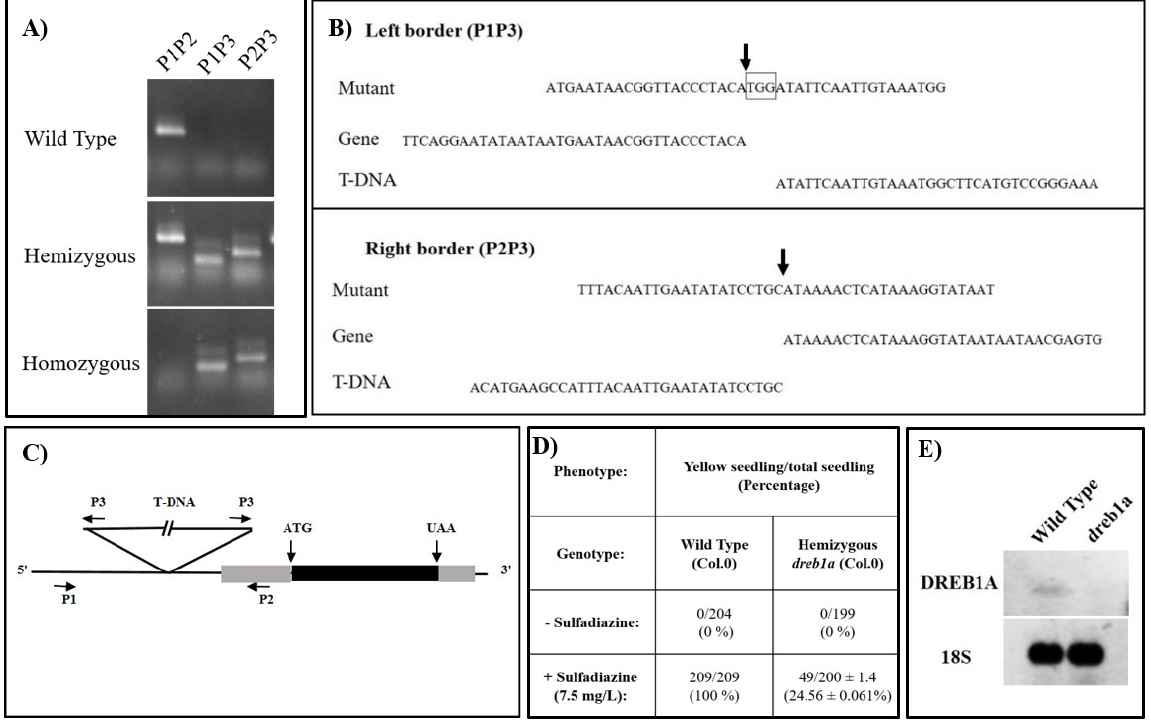
Fig. 1. Molecular identification of the T-DNA insertion in the dreb1a mutant: A) PCR amplifications using DREB1A gene-specific primers (P1 and P2) and the T-DNA specific primers (P3 and P4); B) The status of the T- DNA junctions in the dreb1a plant. Nucleotide sequences of the dreb1a plant were aligned with that of the DREB1A gene and the T-DNA. Arrows indicate the insertion site. The filler sequences are indicated in the box; C) Schematic diagram of T-DNA position in the promoter of DREB1A gene; P, primers used in PCR; Dark Box, coding region; Grey Boxes, untranslated regions (UTRs); ATG, start codon; UAA, stop codon; D) The segregation pattern of sulfadiazine selectable marker in seeds obtained from self-pollination of a hemizygous dreb1 a plant. E) The transcript level of DREB1A gene in wild type and dreb1a seedlings exposed to 4 °C for 2h. 18S rRNA served as an internal